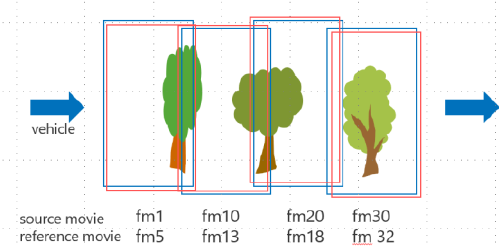
Figure 2. Extraction of the frame image as a reference